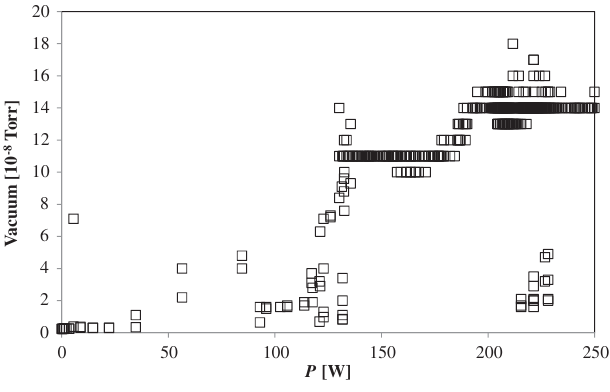
FIG. 18. FPC vacuum vs rf power.